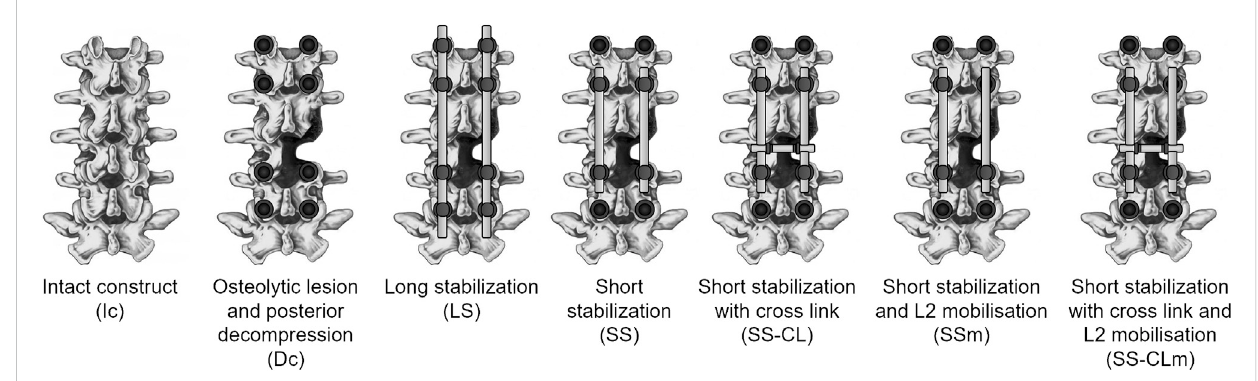
FIGURE 3 Representation of the seven con fi gurations realized for the comparative analysis, showing only the lumbar segment